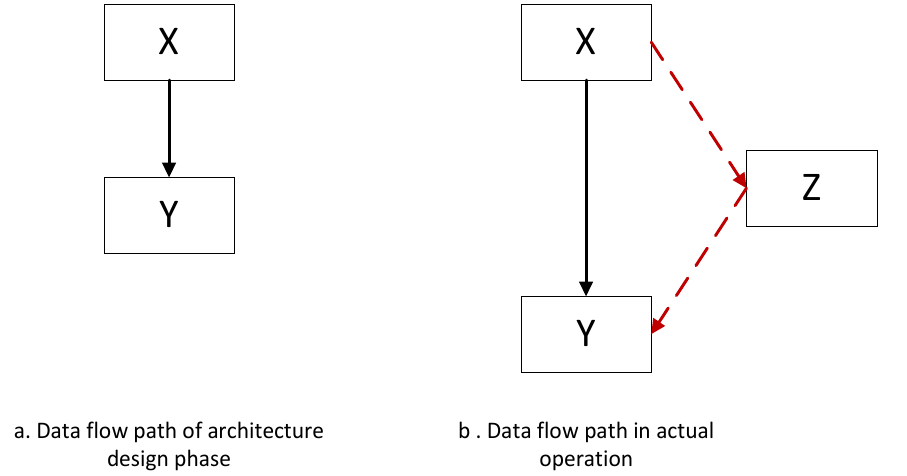
Figure 4. Data flow path of ( a ) architecture design phase vs. ( b ) data flow path in actual operation.